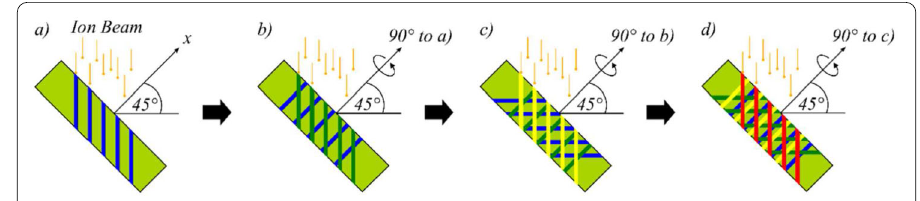
Figure 1 Irradiation scheme for network templates with intersecting pores. The polymer foils are irradiated sequentially from four different directions ( a )–( d ) using swift heavy ions. During each irradiation step, the foil is tilted by 45° towards the incoming ion beam. From M.F.P. Wagner, PhD Thesis, Technische Universität Darmstadt, 2018 [1, 4]